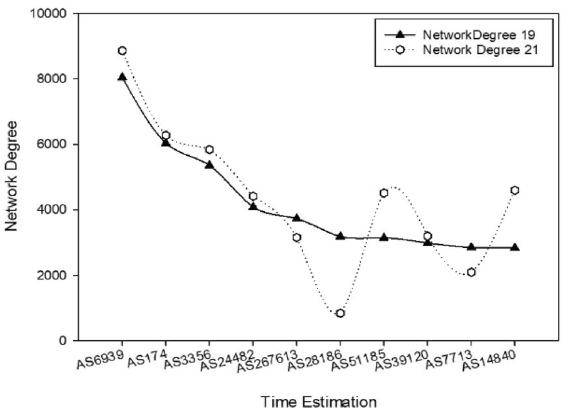
Figure 1. Dynamics of global autonomous system (AS) neighbors from 2019 to